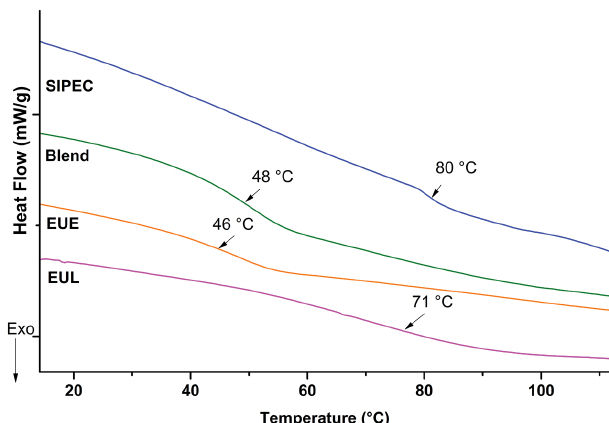
FIGURE 3 - DSC thermograms for individual polymers, SIPEC, and a physical blend with the same nominal composition.